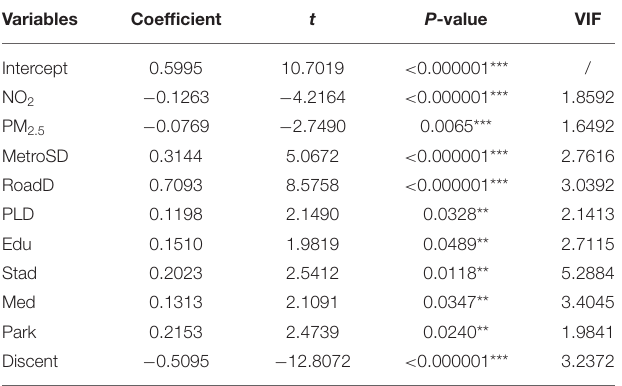
TABLE 4 | Results of Moran’s I test.